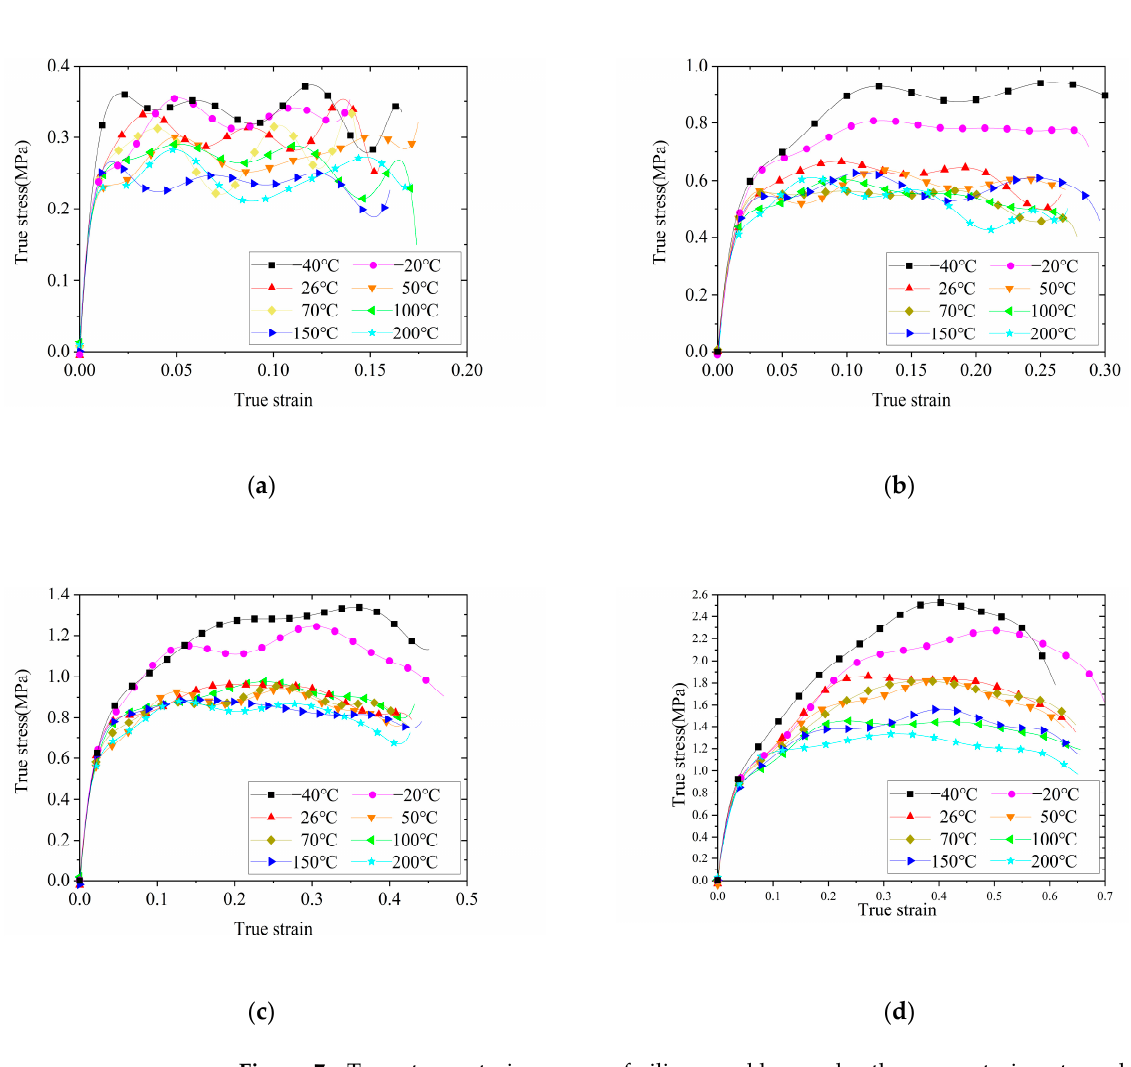
Figure 7. True stress–strain curves of silicone rubber under the same strain rate and different tem- peratures: ( a ) 1200 s − 1 ( b ) 2800 s − 1 ( c ) 4700 s − 1 ( d ) 7200 s − 1 . temperatures: ( a ) 1200 s − 1 ( b ) 2800 s − 1 ( c ) 4700 s − 1 ( d ) 7200 s − 1